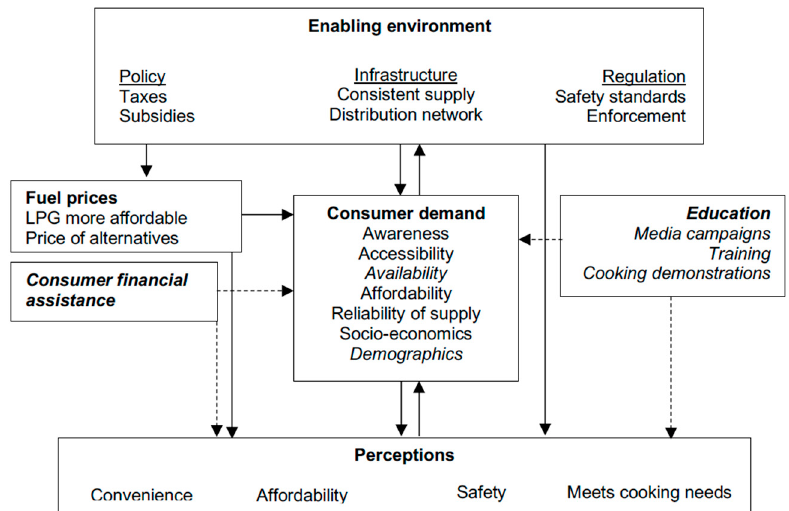
Figure 3. Interventions which would target some of the key factors effecting LPG uptake and exclusive use (adapted from Rosenthal et al. [72] (p. A6). New additions in italics).